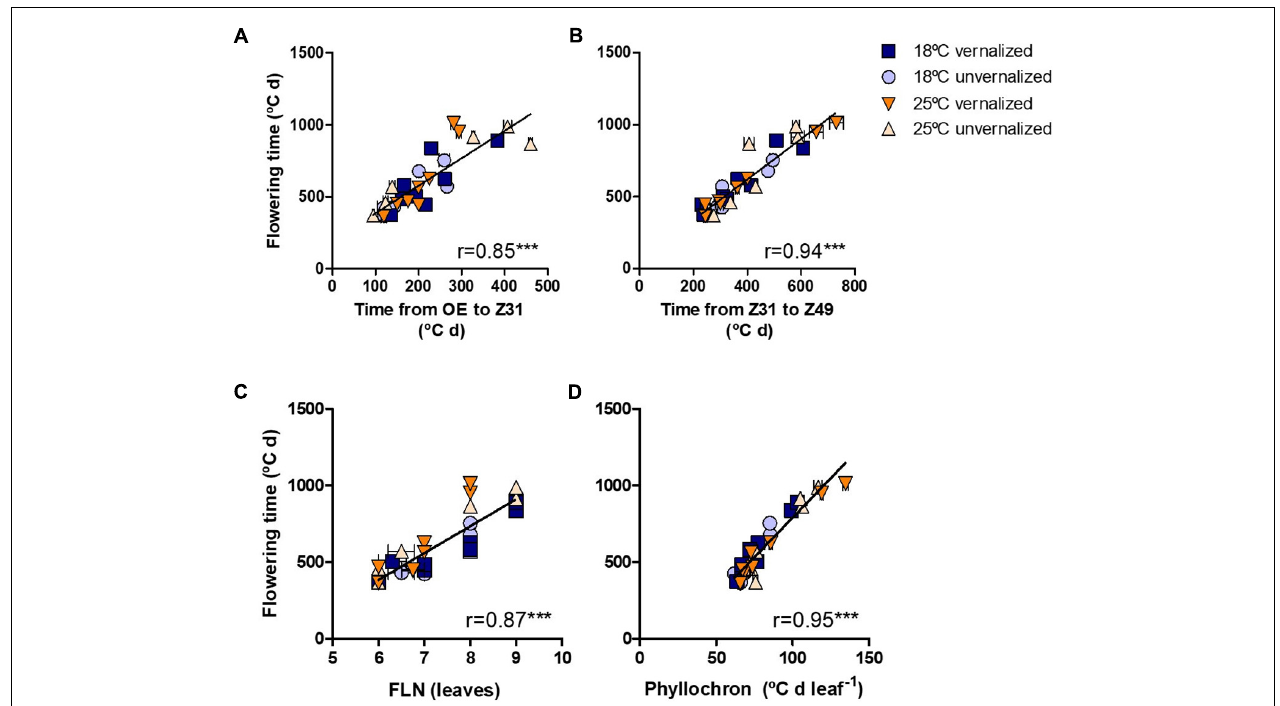
FIGURE 3 | Relationship between time until flowering (Z49) and (A) duration from OE-onset of experiment to onset of stem elongation (Z31), (B) duration of the late reproductive phase (Z31-49), (C) final leaf number, and (D) phyllochron for eight NILs subjected to non-vernalized conditions at 18 ◦ C (circles) or 25 ◦ C (triangles) and those which were vernalized and then grown at 18 ◦ C (squares) or 25 ◦ C